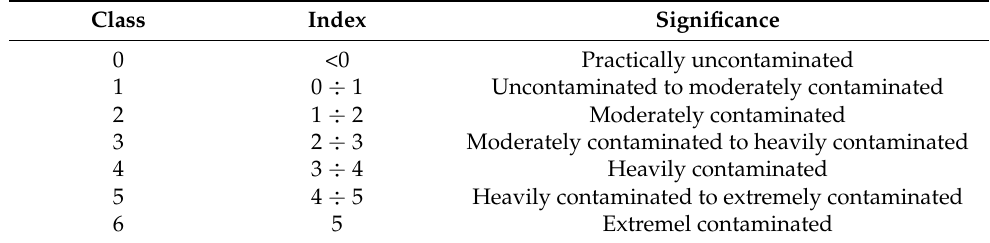
Table 3. Contamination categories based on I geo